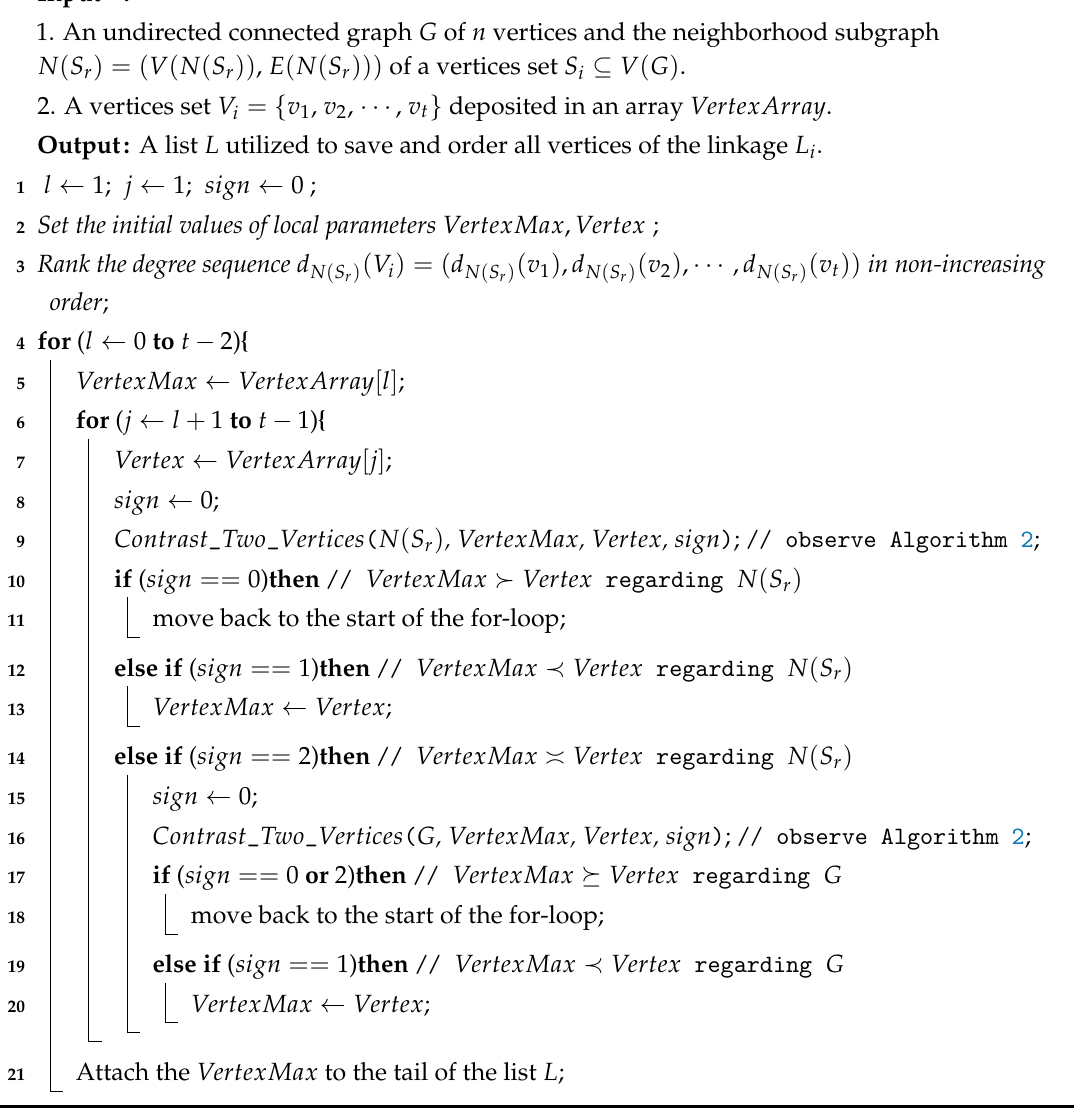
Algorithm 1: Order all vertices of V i into a sole linkage L i for a neighborhood subgraph N ( S r ) with i = 1, 2, 3, 4, respectively where V 1 = V ( N ( S 1 )